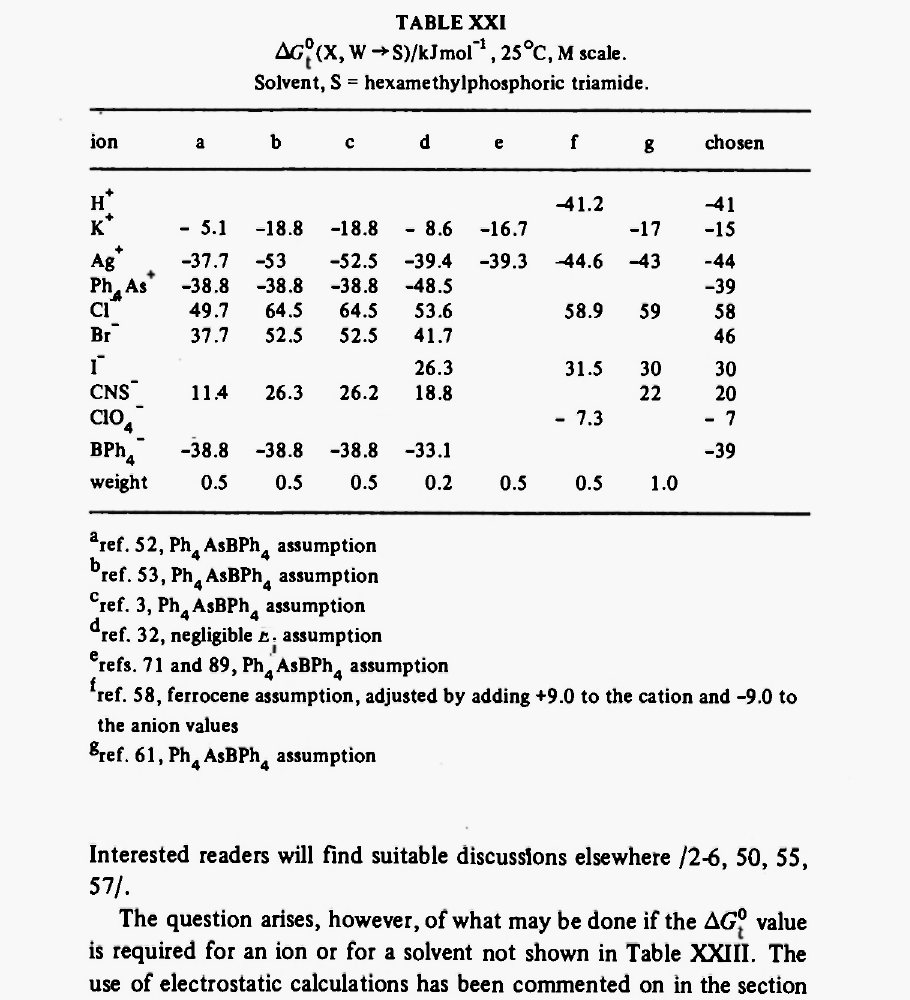
Δσ °(Χ, W->S)/kJmof', 25°C, Μ scale. Solvent, S = hexamethylphosphoric